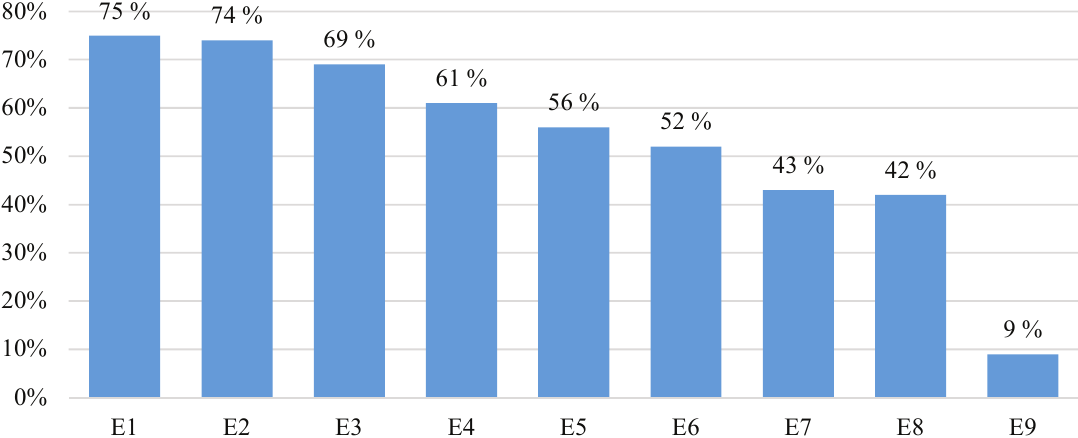
Fig. 8. Distribution of elements of corporate culture that affect the reputation of NUPh and increase the level of HEI brand awareness: E1 – availability of NUPh development strategy, E2 – availability of effective communications, E3 – introduction of effective management technologies, E4 – creating conditions for self–realization, E5 – providing disciplines, E6 – democratic relations with the staff and students of higher education, E7 – collegiality in decision–